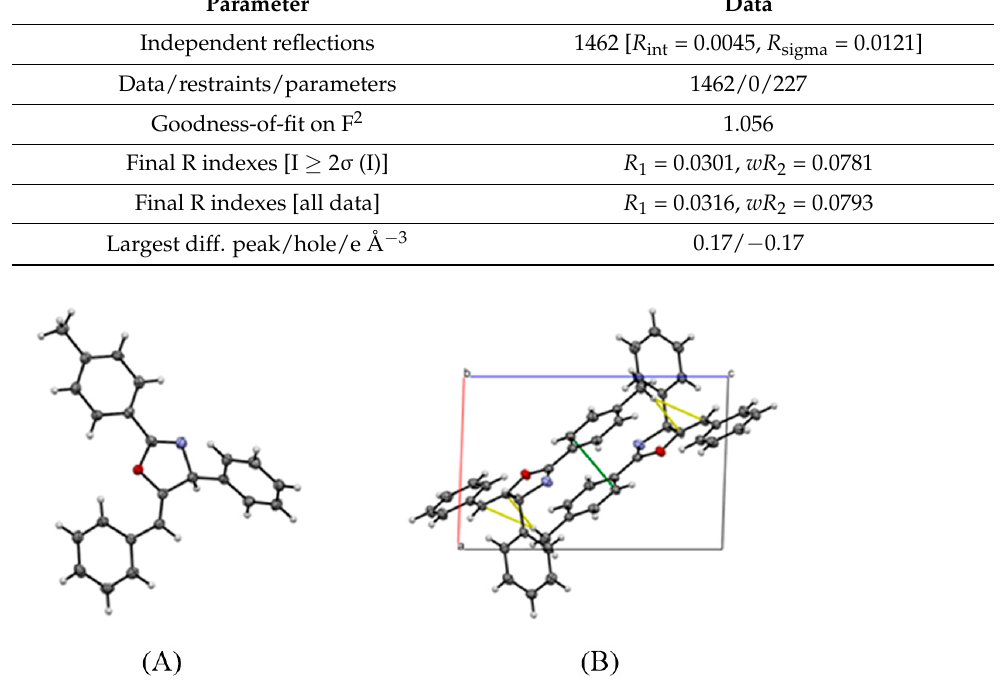
Figure 1. (A) ORTEP diagram of ( Z )-5-benzylidene-4-phenyl-2-( p -tolyl)-4,5-dihydrooxazole ( 15 ) with thermal ellipsoids at the 50% probability level. (B) Packing diagram of 15 along the b axis. Atom colors: (a) blue = nitrogen, (b) white = hydrogen, (c) red = oxygen, (d) grey = carbon. Interaction colors: (e) green line = π−π stacking interaction, and (f) yellow line = CH- π interaction. Table 1. Summary of the crystallographic data and refinement statistics for 15 .